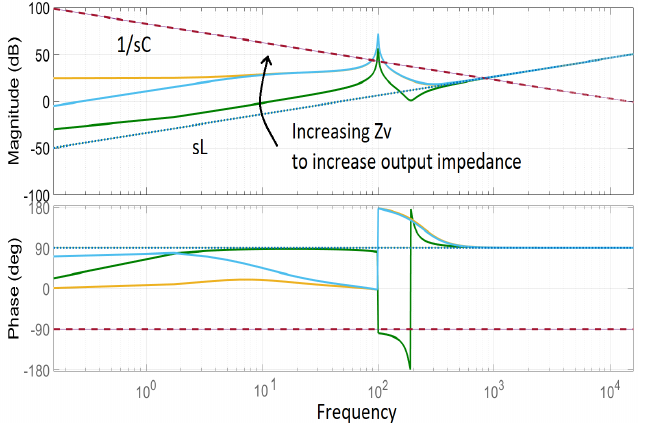
Figure 19. Variation output impedance with